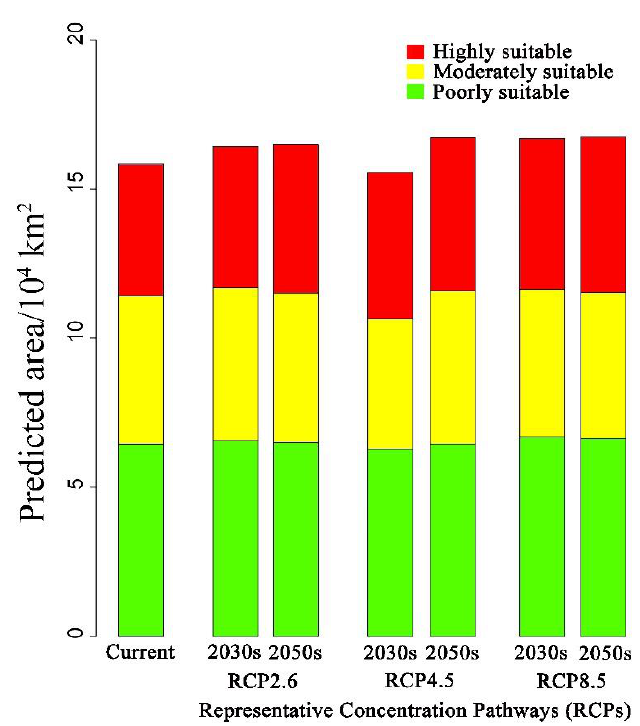
Figure 5. Predicted areas of different habitat suitability classes for Dendroctonus armandi .